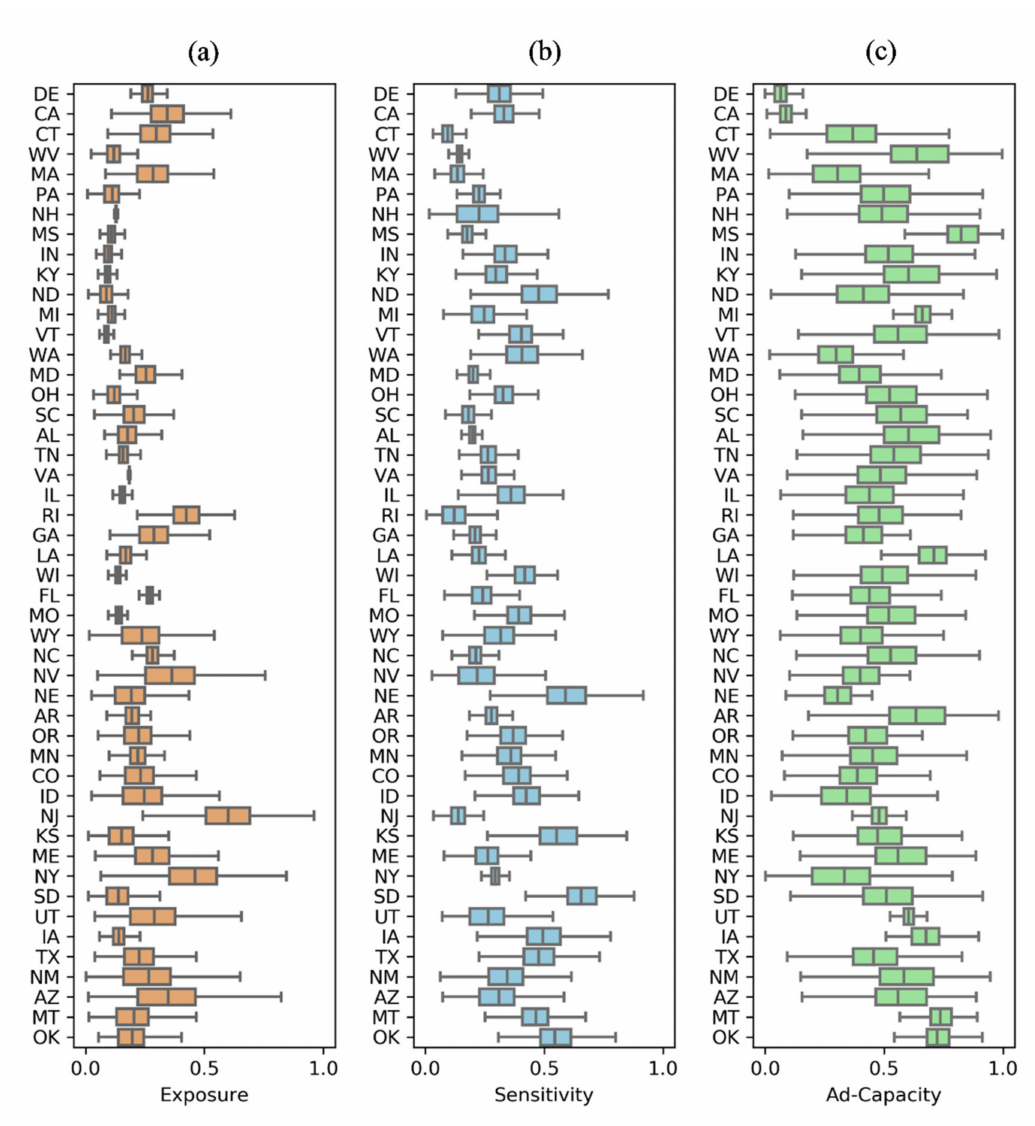
Figure 6. Distribution of DVIs per category (( a ) Exposure, ( b ) Sensitivity, and ( c ) Adaptive Capacity) using the random weighted averaging